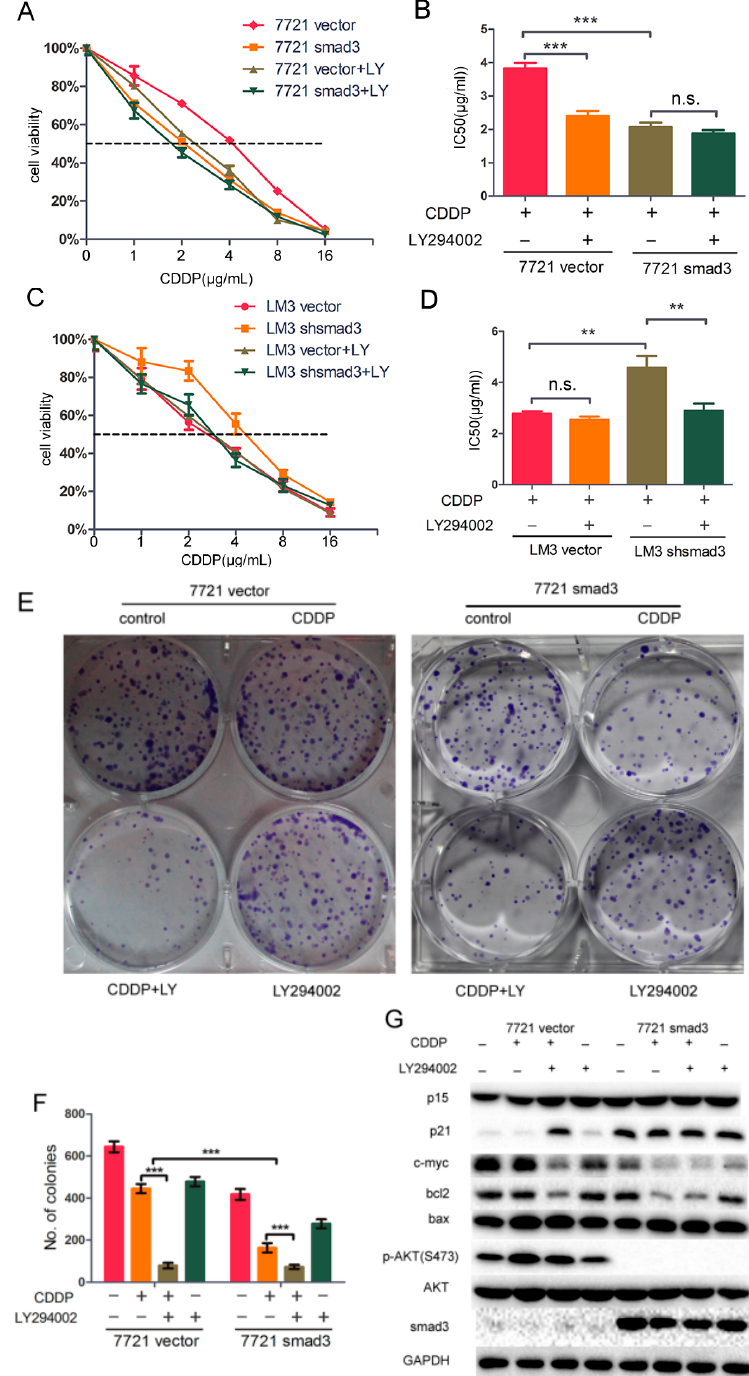
Figure 6. LY294002 restores chemosensitivity of HCC in smad3-defeciency cells. ( A – D ) SMMC-7721 and HCC-LM3 cells were treated with indicated concentrations of cisplatin with or without LY294002 for 72 h. The number of viable cells was determined by CCK-8. IC 50 values were calculated and analyzed by Graphpad Prism 5.0. Data are presented as mean ± S.D. from triplicate wells; ( E , F ) Plate colony formation assay was performed to detect the synergistic effects of cisplatin and LY294002, and the number of colonies was evaluated 14 days after cell plating. The data are presented as the mean ± S.D. from three wells; ( G ) SMMC-7721 cells were treated with cisplatin and/or LY294002 for 48 h and cell lysates were used for Western blot assays. All of the experiments were performed in triplicate ( ** p < 0.01, *** p < 0.001; n.s. means no significance).